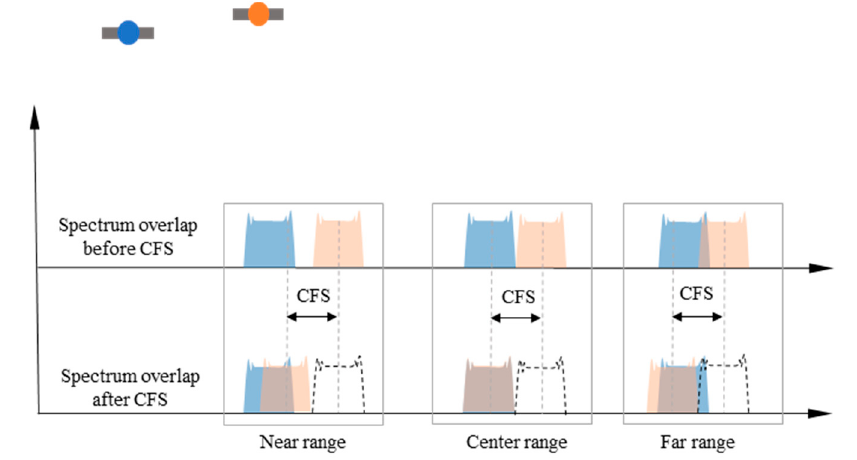
Figure 10. Spectrum overlap before and after CFS along the range direction.